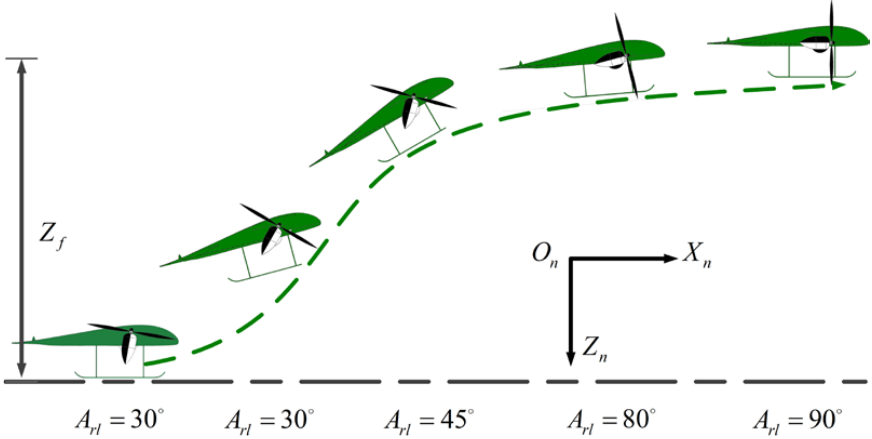
Figure 11. The flight path of TTO scheme. Figure 12, the equation of state as (14) of the TTO scheme can be further expressed as: